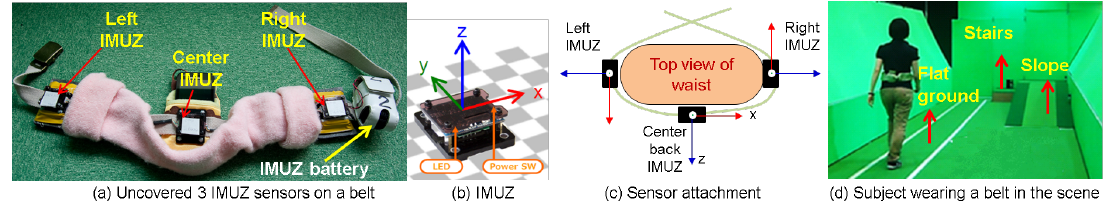
Figure 1. Setup of the sensor-based human gait data capturing system: ( a ) Waist-belt (uncovered) having three IMUZ sensors; ( b ) three axes of a typical IMUZ sensor; ( c ) Sensors’ attachment at left, right, and center-back position; and ( d ) Real data collection image, where a subject is wearing a belt, and flat ground, stairs and slope are highlighted in the environment. (This Figure was previously published in [17] as Figure 8. Hence, it is reprinted from [17], Copyright (2015), with permission from Elsevier).